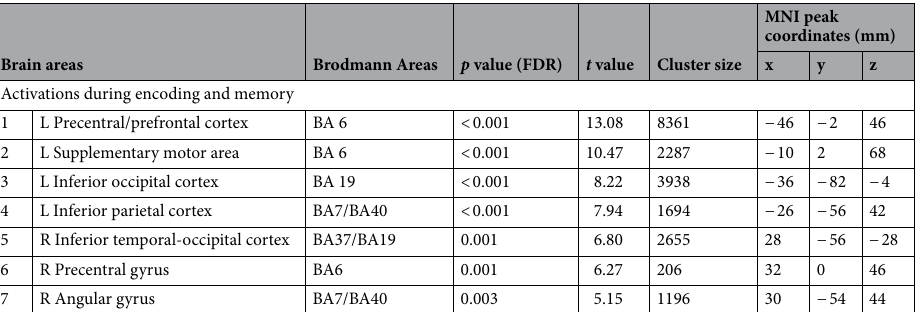
Table 2. Significant areas of activation during encoding and memory (threshold at FDR 0.05). Peak coordinates in MNI space are listed using the Talairach coordinate system. t values are reported for magnitude of activation. Anatomical labels for peak coordinates were derived from the MRIcroN software. L, Left; R, Right.